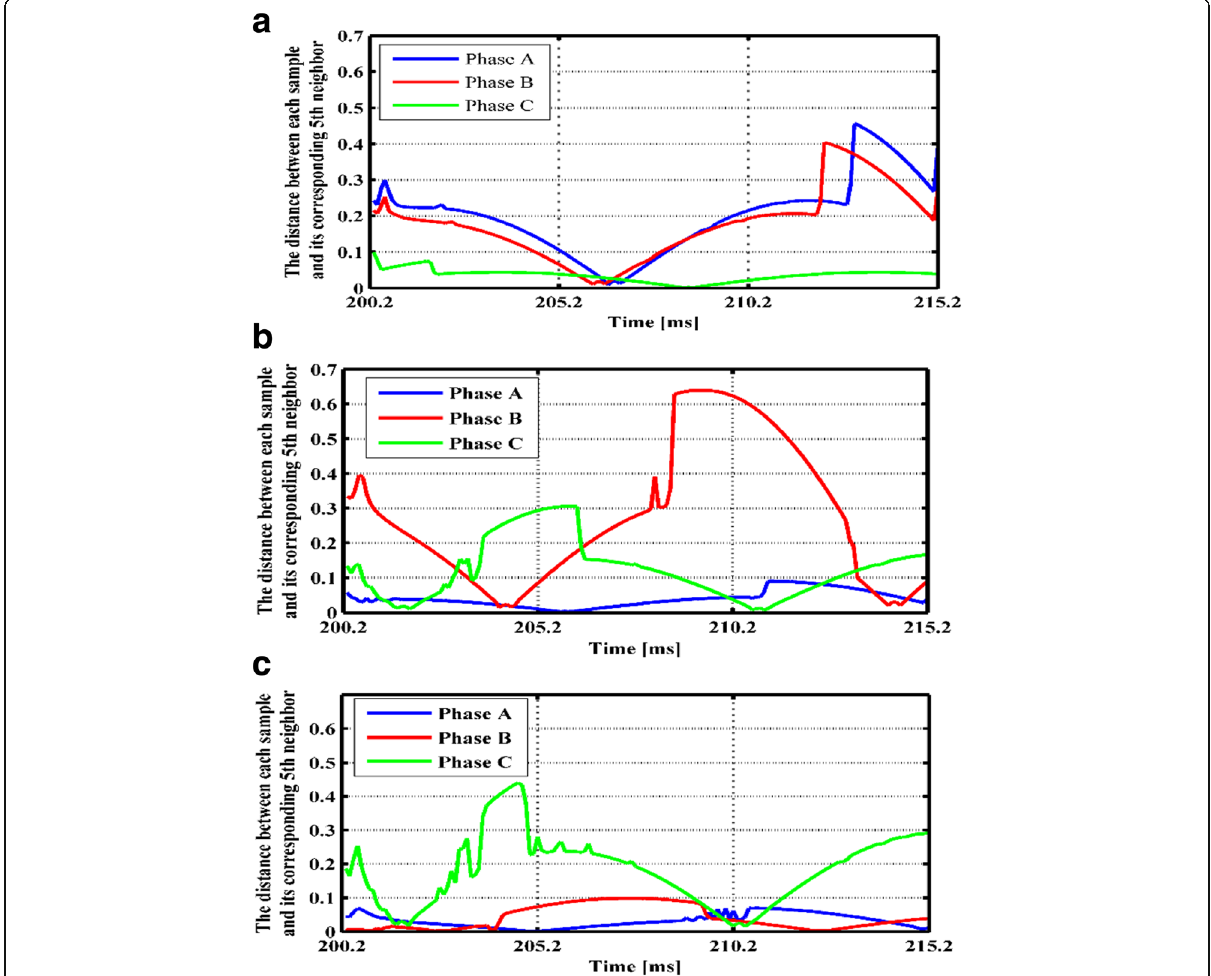
Fig. 4 The distance between each sample and its corresponding neighbor in the analysis window. a Fault AB, negligible resistance, t0 = 0.2002 s. b Fault BCg, negligible resistance, t0 = 0.2002 s. c Fault Cg, negligible resistance, t0 = 0.2002